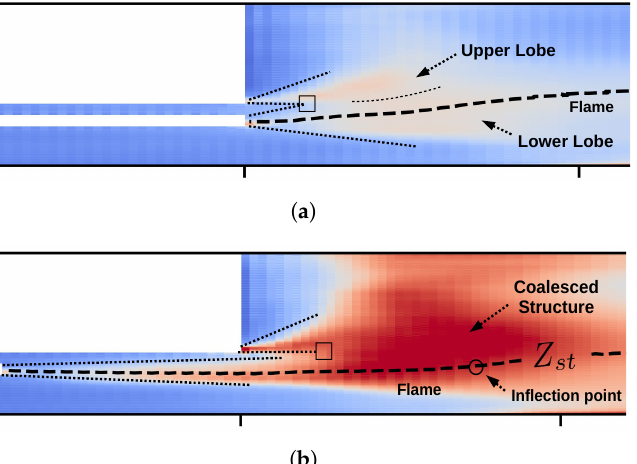
Figure 13. Close up view of u RMS in the near field of the jet for ( a ) DP-A and ( b ) DP-C. Both upper and inner-shear layers are denoted by thin dotted lines, whereas the flame location is indicated in thick dashed lines. In ( a ), the upper and lower lobes of mild fluctuations are identified. For ( b ) the approximate location of the inflection point in the stoichiometric line is signaled by ◦ . The position where upper and fuel-rich inner shear-layers commingle is indicated by (cid:3)